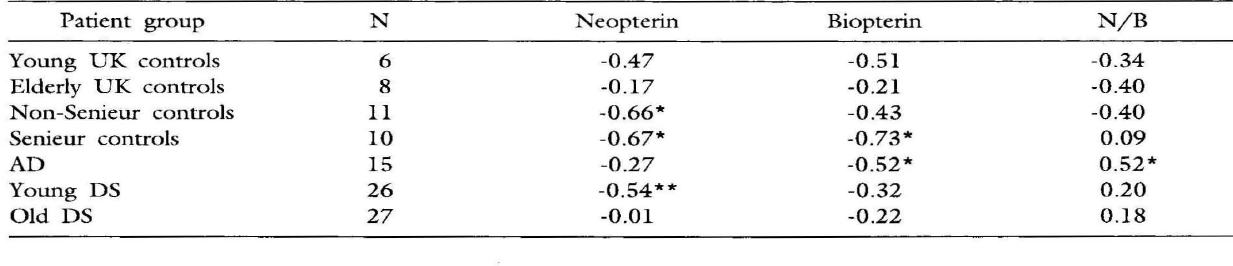
Table 2. Correlations (Pearson's'r' ) between the levels ofneopterin, biopterin, the neopterin/biopterin ratio (N/ B) ra tio and patient age within each patient group (*P<0.05, **P<O.Ol